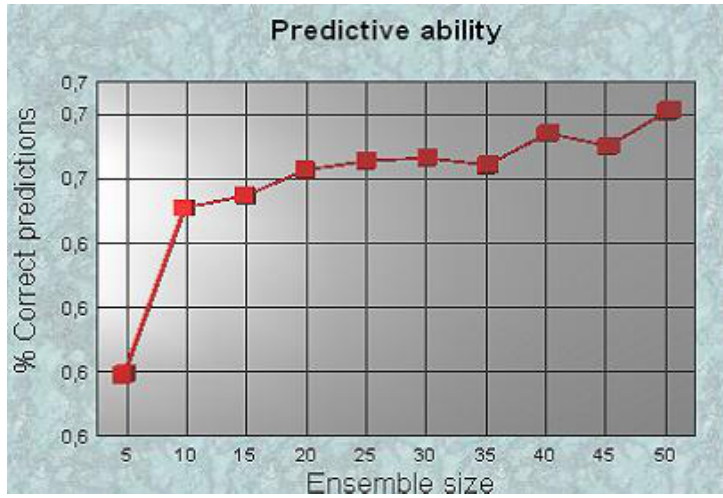
Figure 5: Relationship between ensemble size and predictive